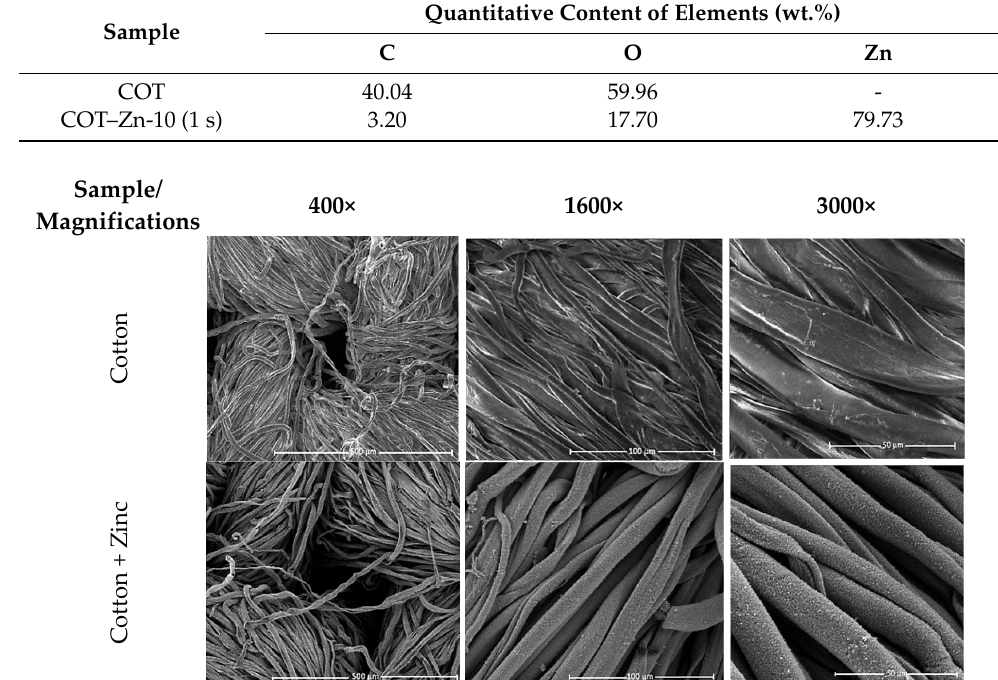
Figure 1. SEM results (magnifications: 400 × , 1600 × , and 3000 × ) of the tested samples recorded before and after magnetron sputtering with a zinc target.